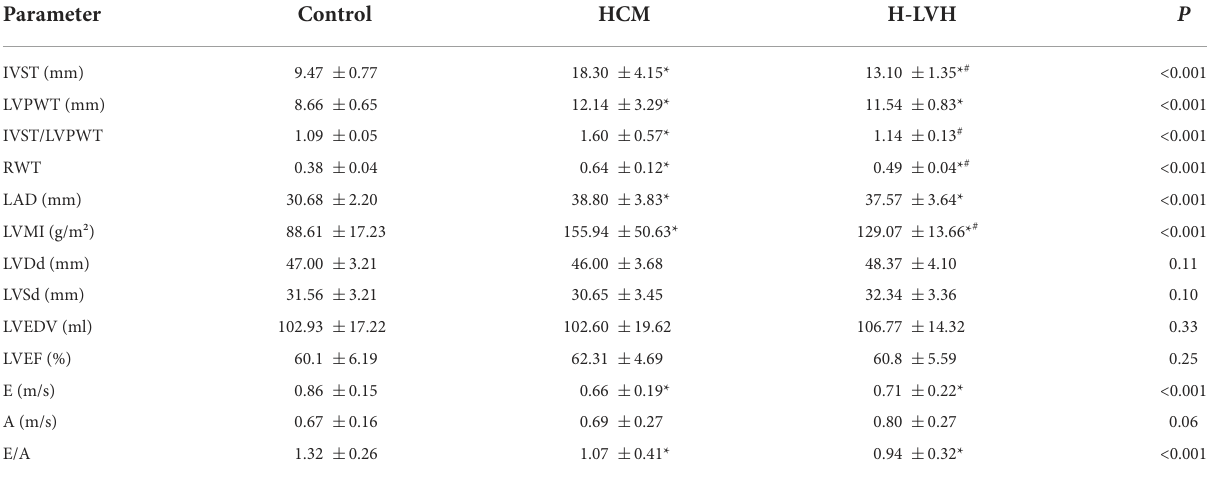
TABLE 2 Comparison of echocardiographic parameters for study groups.